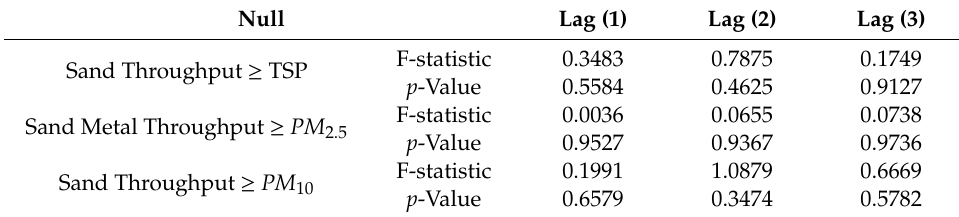
Table 6. Granger causality of sand and fine